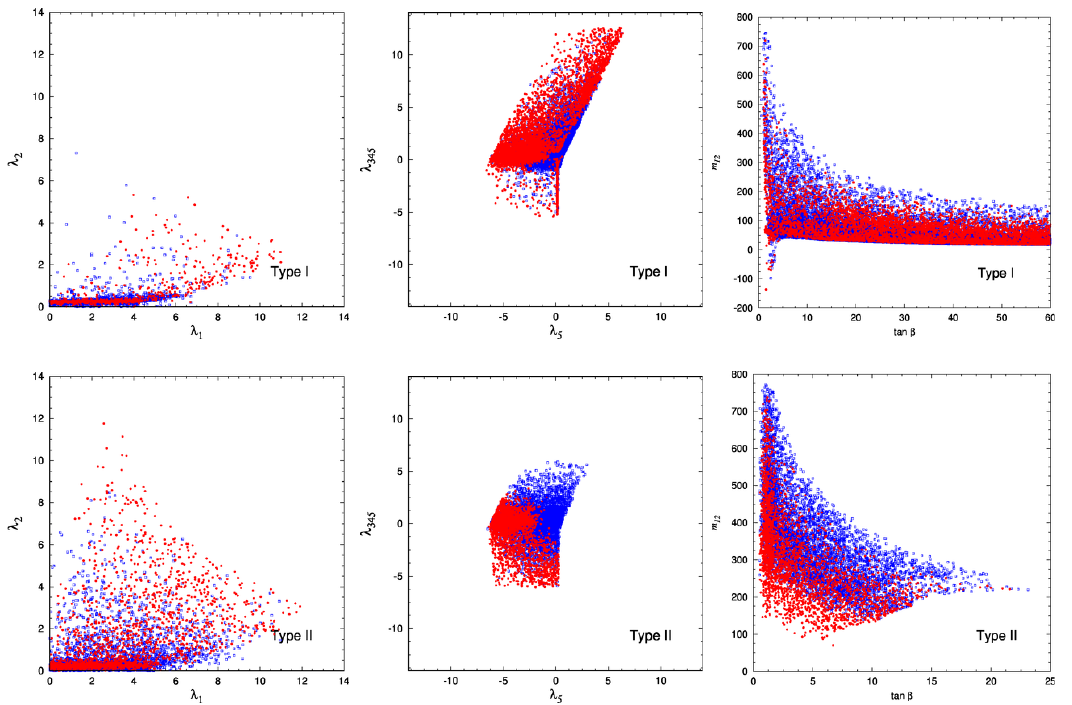
Figure 6 . The mapping of the (cid:12)rst order (red circles) and second order (blue boxes) PT points on the 2D space of model parameters: (cid:21) 1 vs. (cid:21) 2 (left), (cid:21) 345 vs. (cid:21) 5 (middle) and m 12 vs. tan (cid:12) (right). Only T c (cid:20) 300 GeV points are retained. Note that all the points with tan (cid:12) > 25 in Type II model have been excluded by the H; A ! (cid:28)(cid:28) bounds [56,